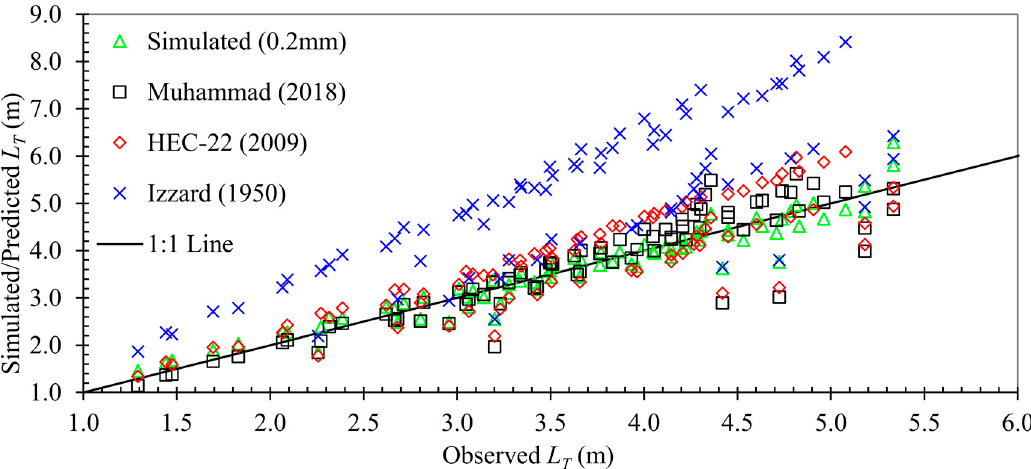
Figure 3. Comparison of simulated/predicted and observed 100% interception curb inlet length L T for 80 laboratory tests by Wesley